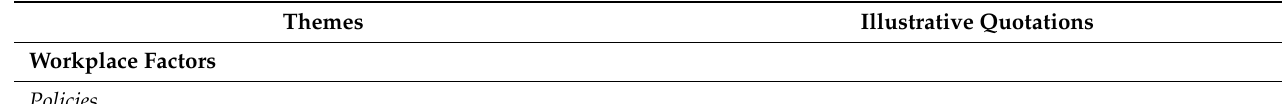
Table 4. Illustrative quotations describing respondents’ perceptions of factors related to presenteeism intentions from a national sample of U.S. food system workers during early